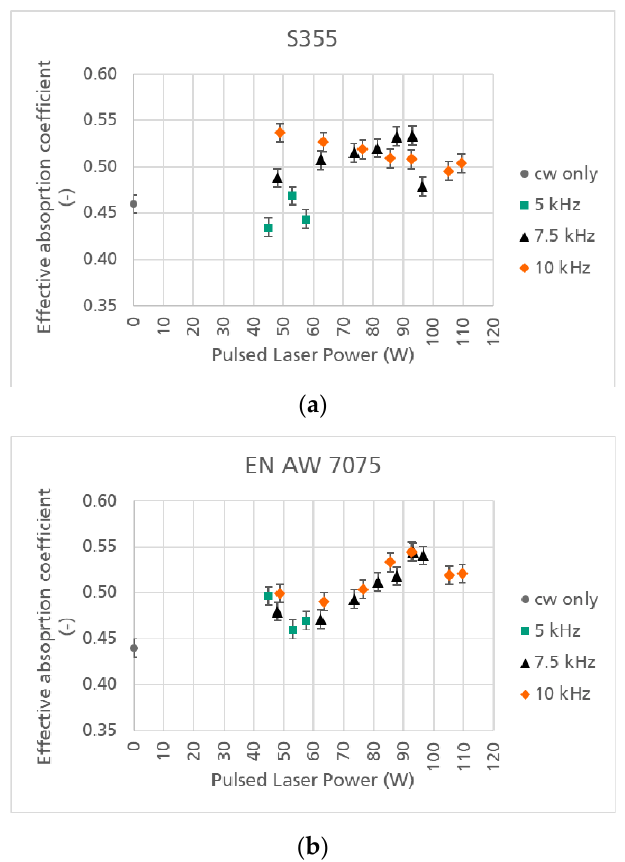
Figure 4. Graphic representation of the calculated effective absorption coefficients for the S355 ( a ) and EN AW 7075 ( b ) samples processed at 400 W continuous laser power and different pulsed laser frequencies and powers.